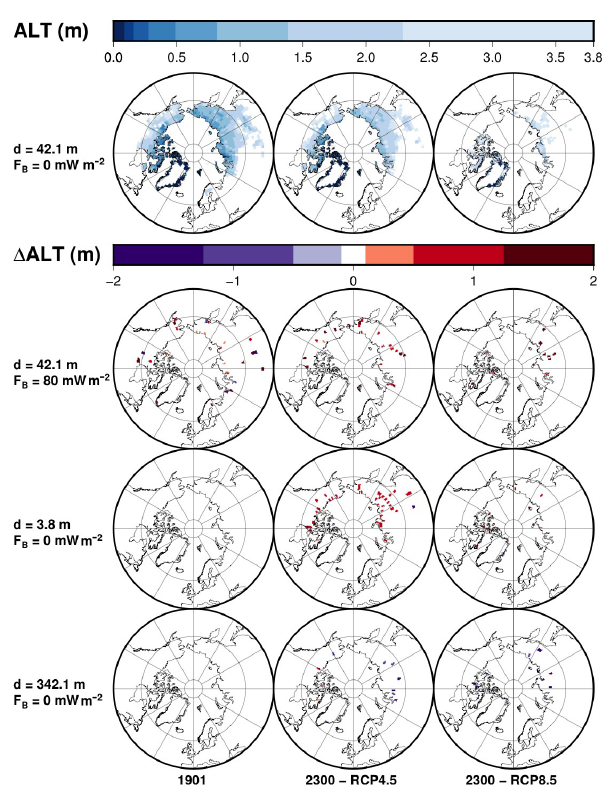
Figure 11. Active layer thickness for the unmodified model (top row) and differences to the original model at each time frame for the modified model with 80mWm − 2 (second row), the modified model with d = 3 . 8m (third row) and the modified model with d = 342 . 1m (bottom row). Time frames are shown for 1901 and 2300CE for the RCP4.5 and RCP8.5